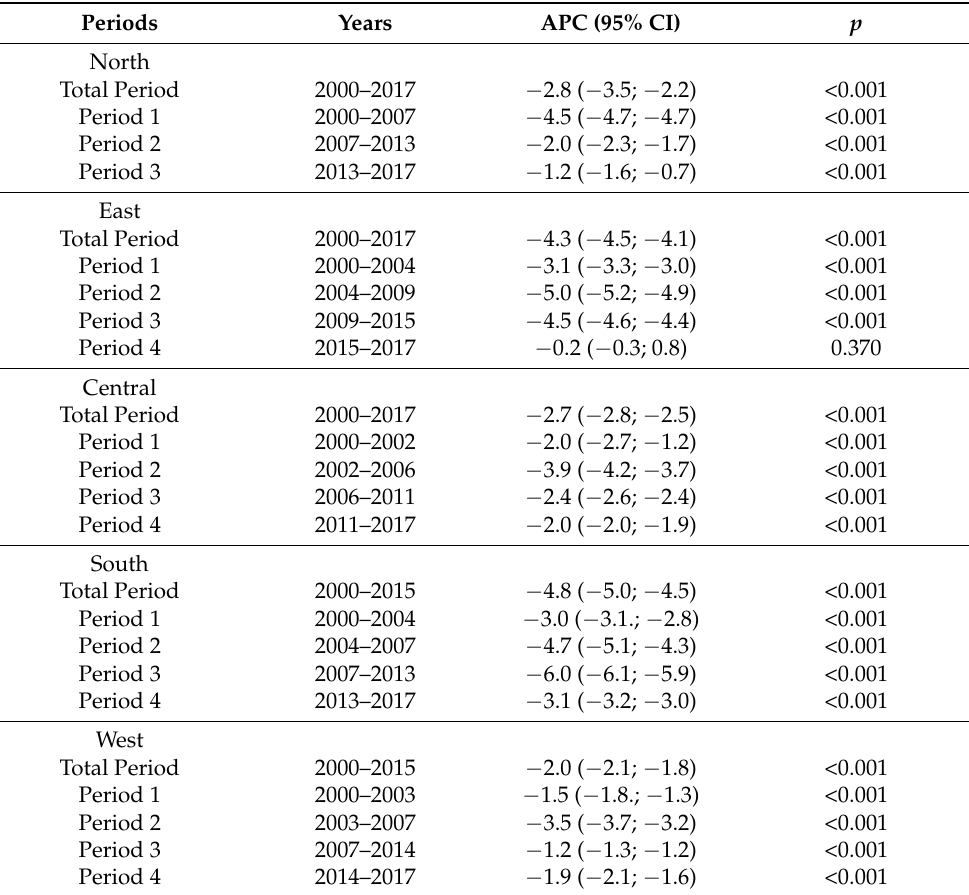
Table 2. Joinpoint analysis for regional maternal mortality rates in Africa, 2000–2017.